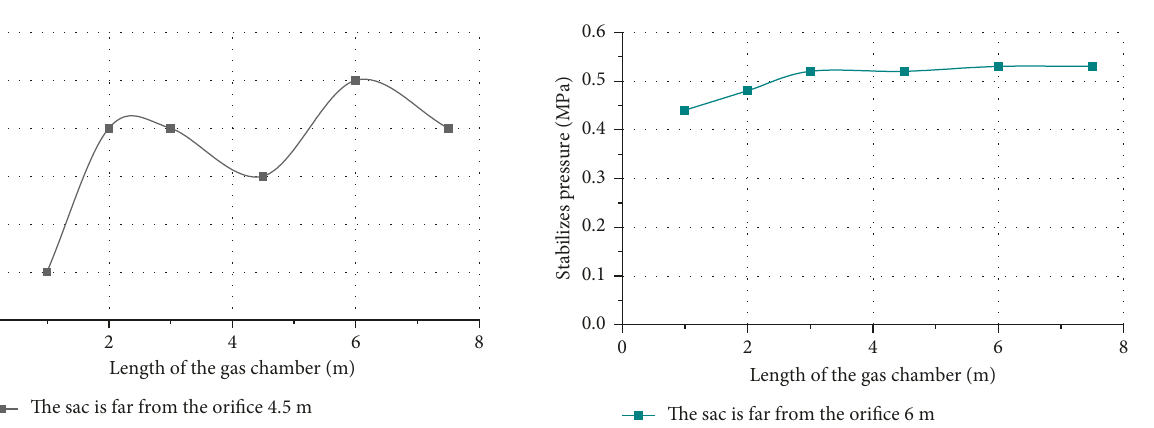
Figure 14: The effect of air chamber length on stable pressure when the sealing hole segment is 6m from the